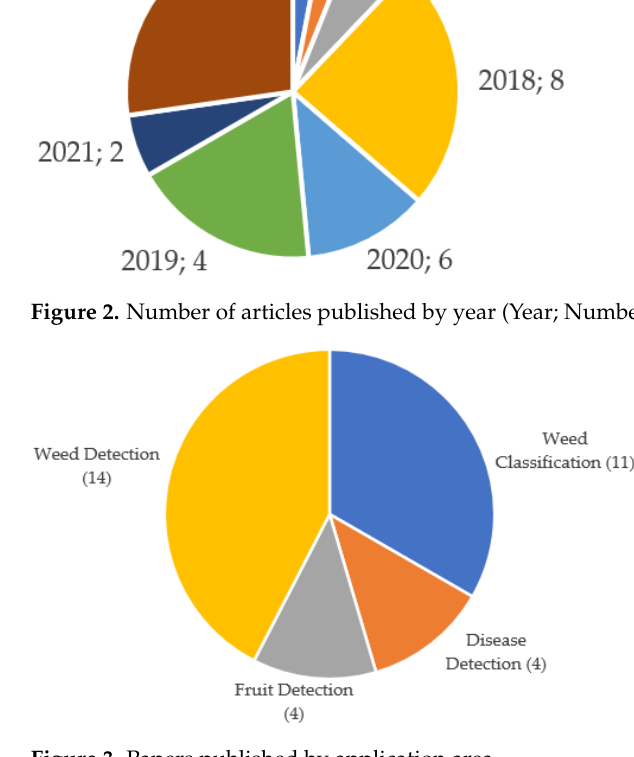
Figure 3. Papers published by application area.